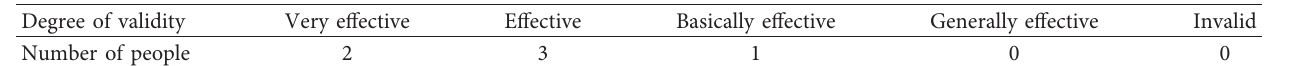
Table 2: List of questionnaire reliability